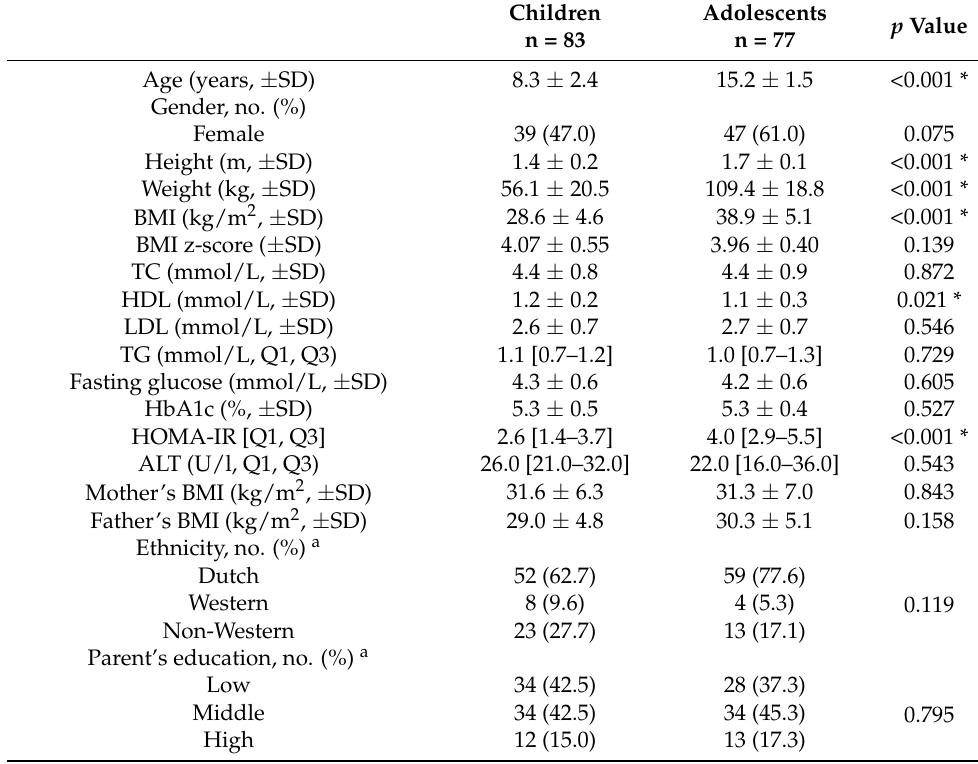
Table 1. Baseline characteristics of the included children and adolescents with severe